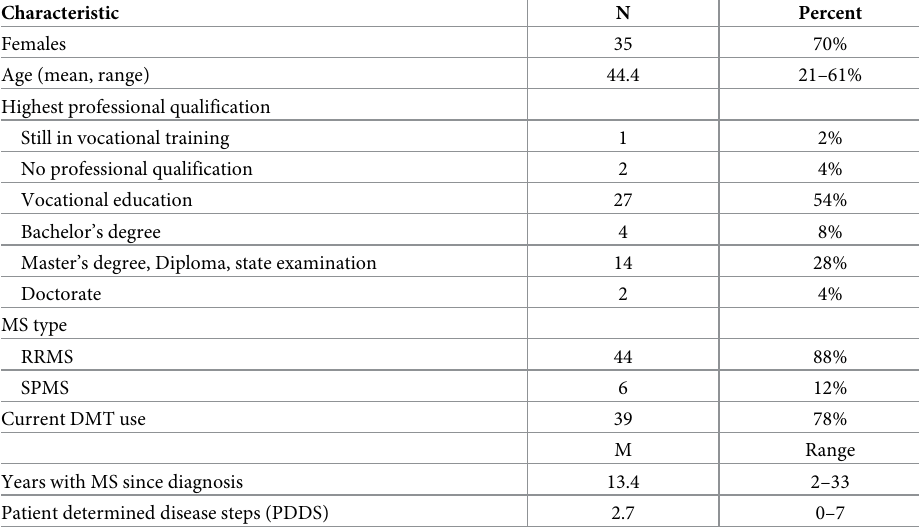
Table 1. Demographic and MS-related characteristics of participants.